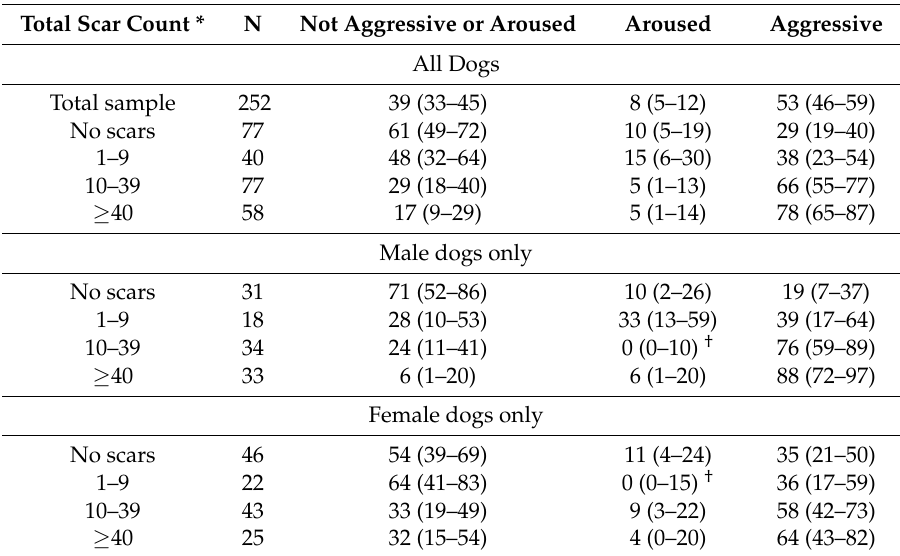
Table 4. Dog-directed arousal and aggressive behavior by scar count in the three body zones most commonly injured in organized dogfighting. Levels of scarring are significantly different from each other if the confidence intervals do not overlap. Fisher’s Exact p for overall association between scar count and behavior was <0.001 for males and 0.05 for